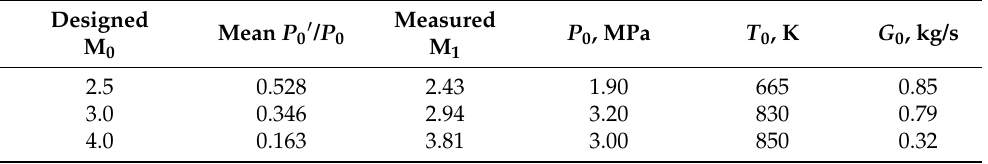
Table 1. Characteristics of the jet flow at the entrance of GG intake.